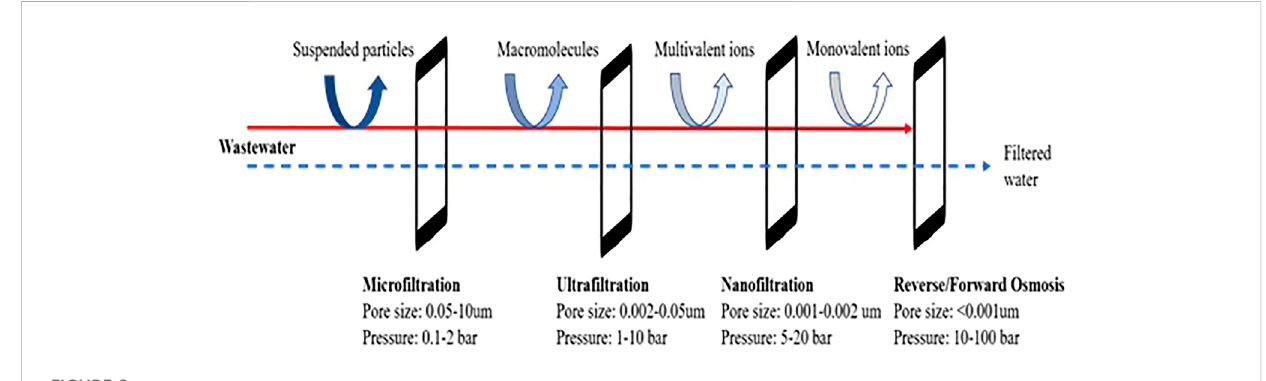
FIGURE 2 Pressure driven membrane systems with their characteristic